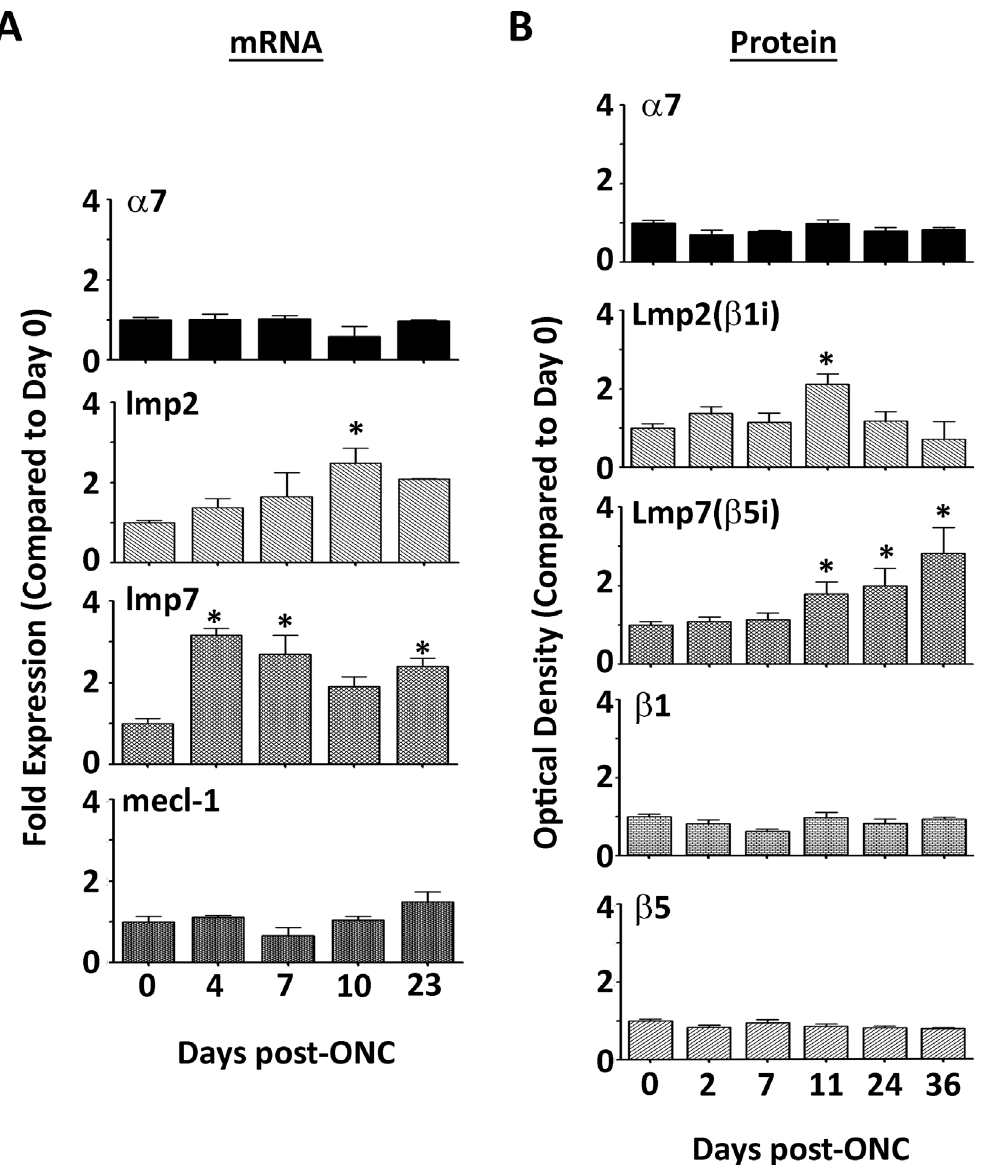
Fig 1. Immunoproteasome Content in the WT Retina after Optic Nerve Crush. ( A, B ) mRNA or protein was isolated from WT retinas at the indicated time points after ONC. ( A ) Results are the fold expression of the shared proteasome subunit α 7 or immunoproteasome subunits lmp2 ( β 1i), mecl-1 ( β 2i), and lmp7 ( β 5i), and are the mean ± S.E. of 3 – 5 ** mice/group compared to control (day 0). ( * , p (cid:1) 0.05 by one-way ANOVA with Dunnett ’ s post-test compared to the ‘ day 0 ’ values). ( ** All 23 day data represent 2 mice/group). ( B ) Results are the optical density of the shared proteasome subunit α 7, standard proteasome subunits β 1 and β 5, and immunoproteasome subunits LMP2 ( β 1i) and LMP7 ( β 5i), and are the mean ± S.E. of 3 – 22 ** mice/group compared to control (day 0). ( * , p (cid:1) 0.05 by one-way ANOVA with Dunnett ’ s post-test compared to the ‘ day 0 ’ values). ( ** All 36 day data represent 2